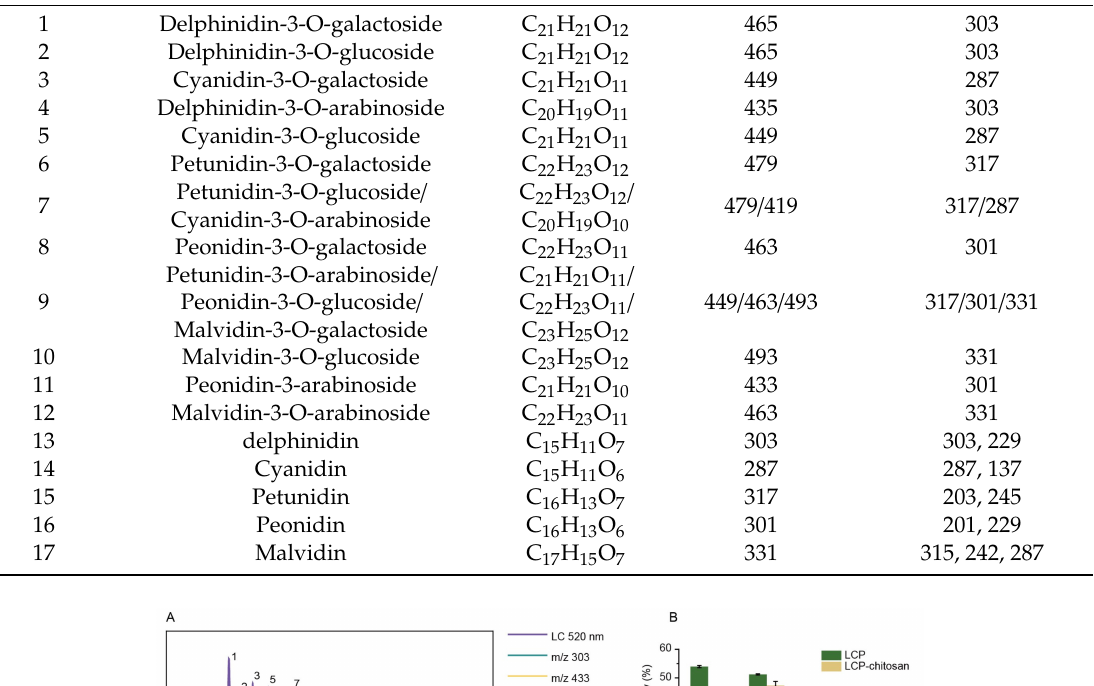
Table1. PeakidentificationofanthocyaninsinMirtoselect ® bilberryextractusingHPLC-UV / vis-MS / MS. Peak #